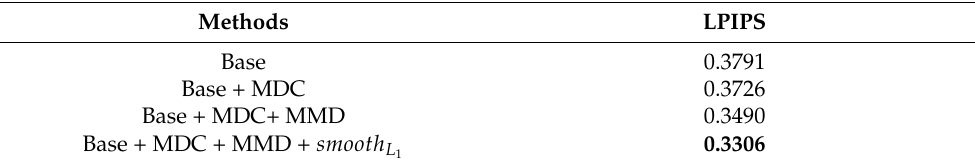
Table A1. Mean value of LPIPS for different ablation experiments. Base represents the base network, MDC represents multilevel dense connection, MMD represents matrix mean discriminator and smooth L means that the pixel loss and perceptual loss are computed by smooth L 1 performance in